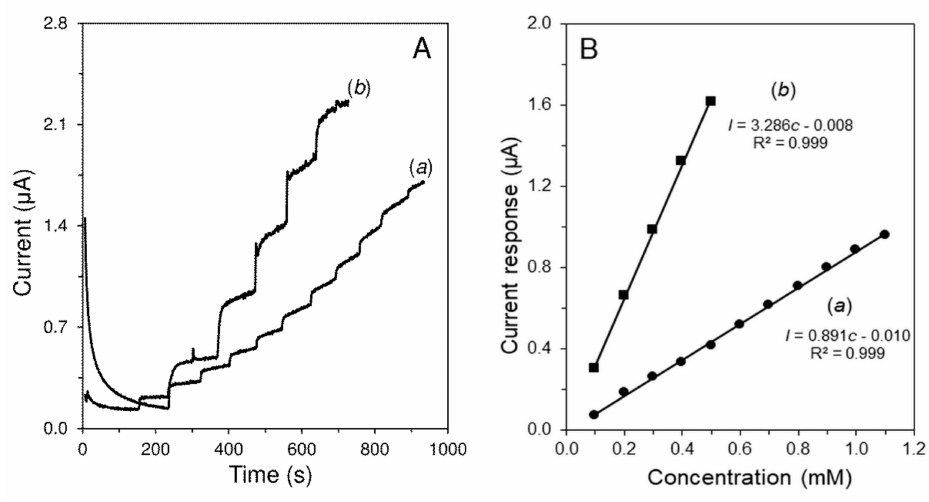
Figure 5. Typical amperometric responses ( A ) and corresponding calibration curves ( B ) of the CPE / RuO 2 / GOx ( a ) and GCE / MWCNTs-RuO 2 / GOx / Nafion ® ( b ) to additions of 110 µ M Glc. Measured in 0.1 M PB of pH 7.0 at potential + 0.4 V and speed of stirring 400 rpm.